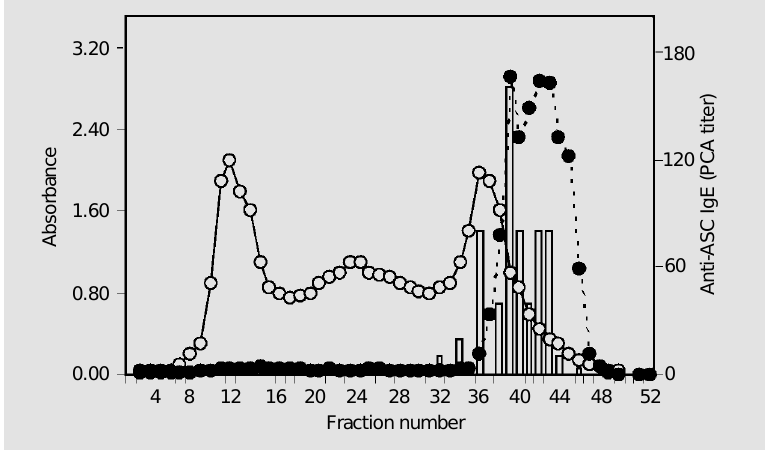
Figure 1. Specificity of mouse anti- Ascaris suum component (MAC-3) monoclonal antibod- ies. The open circles represent the gel filtration profile of A. suum crude (ASC) extract (peak I, fractions 11 to 16; peak II, fractions 26 to 31; peak III, fractions 37 to 50). Thirty milligrams of ASC was applied to a Sephacryl S-300 column and fractions of 2.0 ml were collected with PBS, pH 7.2. Absorbance was determined at 280 nm. Each fraction was injected with alumn adjuvant into BALB/c mice in order to evaluate the IgE antibody production. The bars represent the passive cutaneous anaphylaxis (PCA) titer of mouse sera three weeks after immunization. The specificity of MAC-3 was determined by ELISA using polystyrene plates absorbed with each fraction and incubated with MAC-3 plus a peroxidase-labeled rat monoclonal antibody against mouse IgG1. The filled circles represent the absorbance obtained at 492